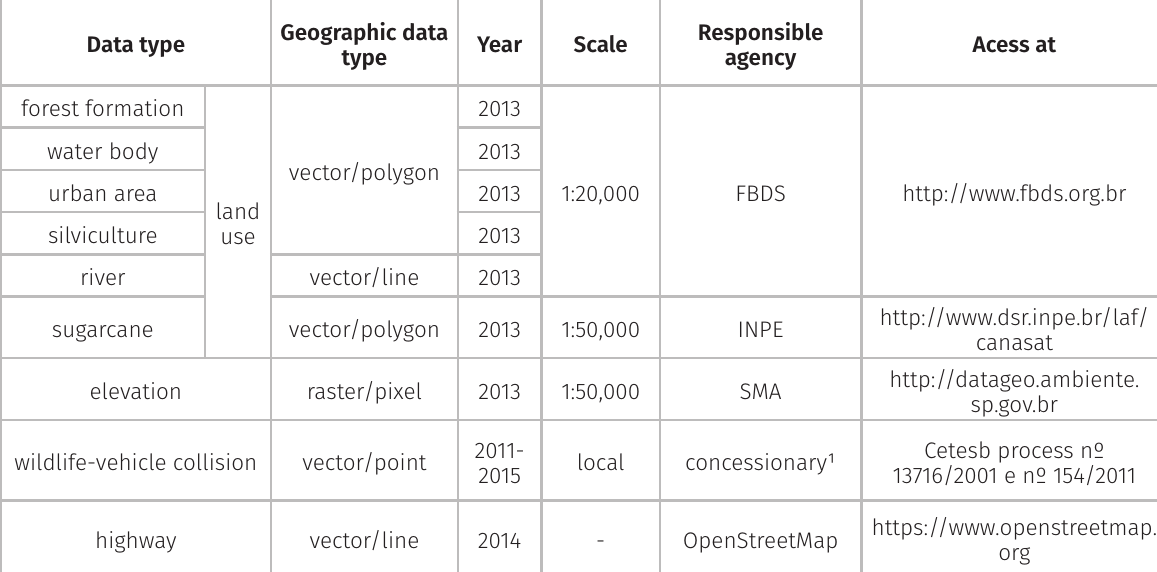
Table I. List of Secondary Spatial Daa used for the research